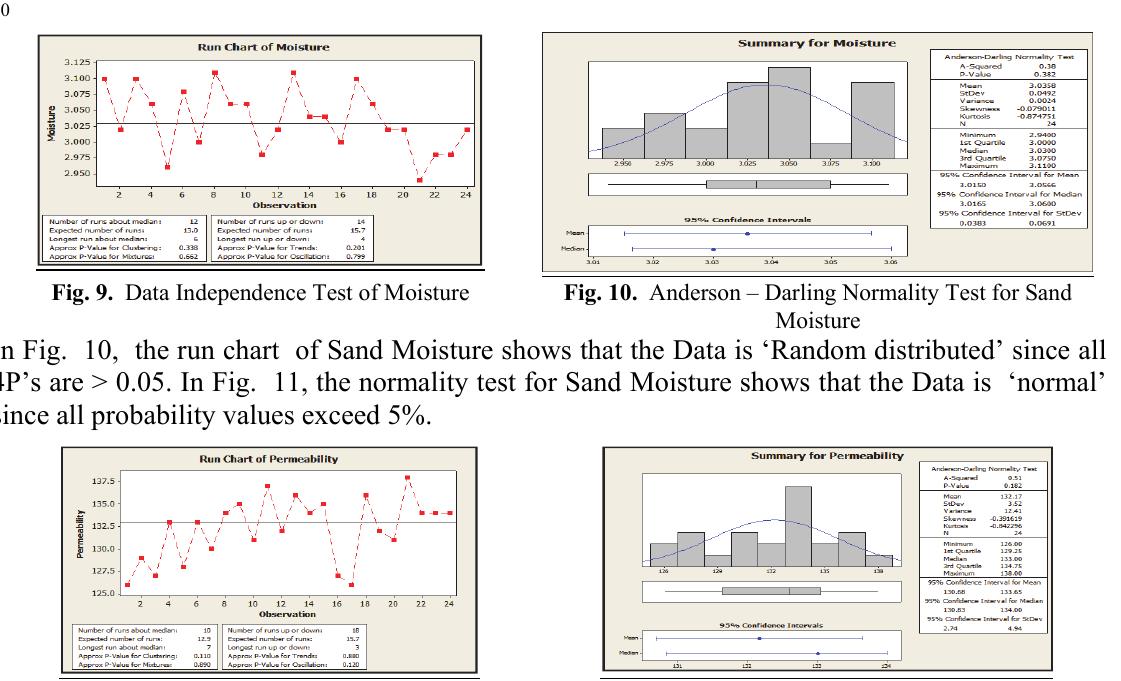
Fig. 11. Data Independence Test of Sand Permeability